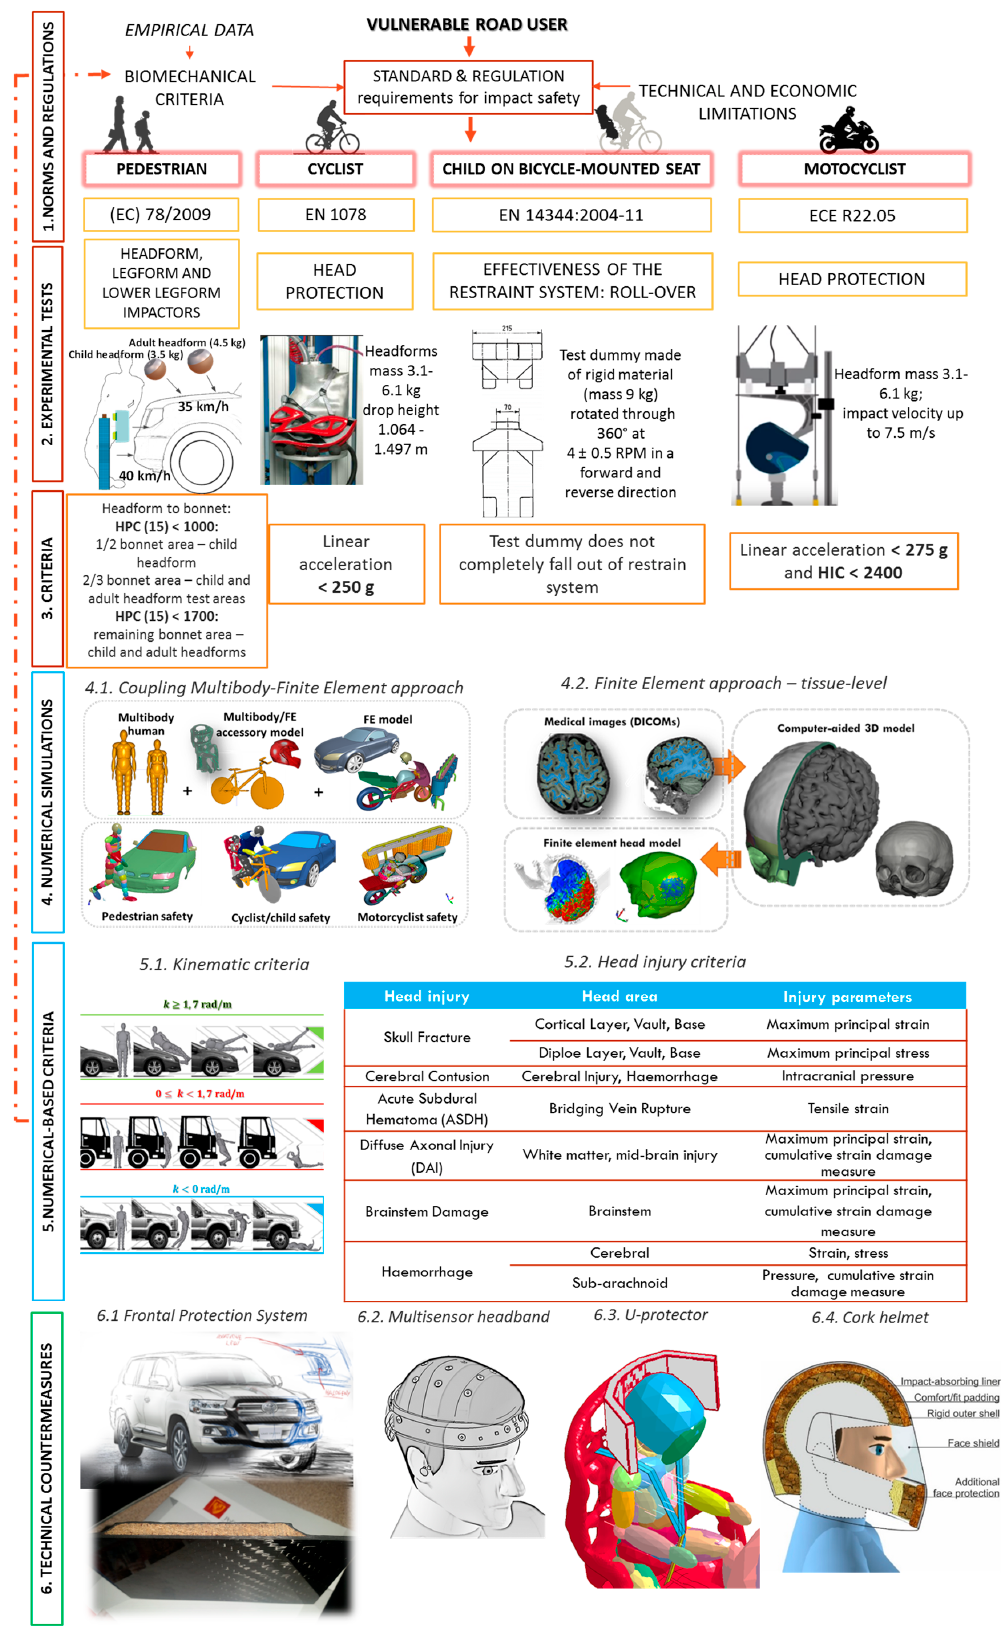
Figure 10. A method to assess and enhance the vulnerable road user safety during impact.